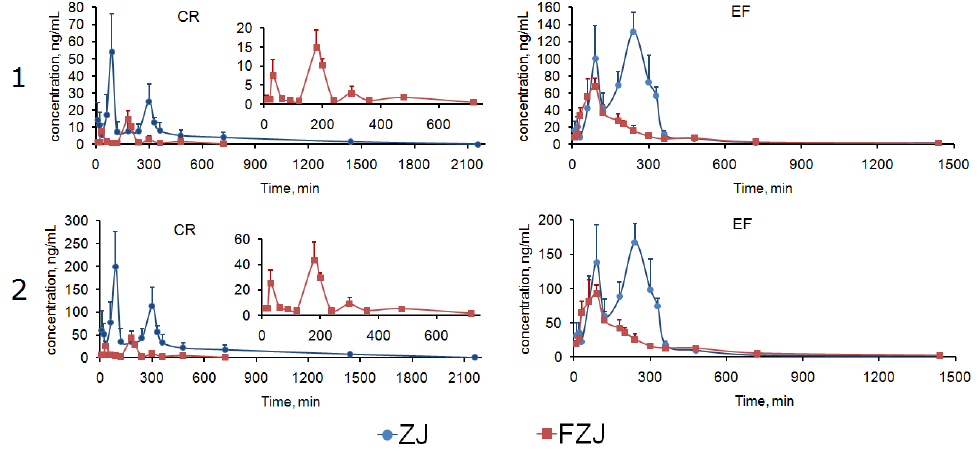
Figure 4. Integrated C–T curves of CR and EF alkaloids calculated by AUC-based weighting method ( 1 ) and total drug concentration method ( 2 ) after oral administration of ZJ and FZJ extract.